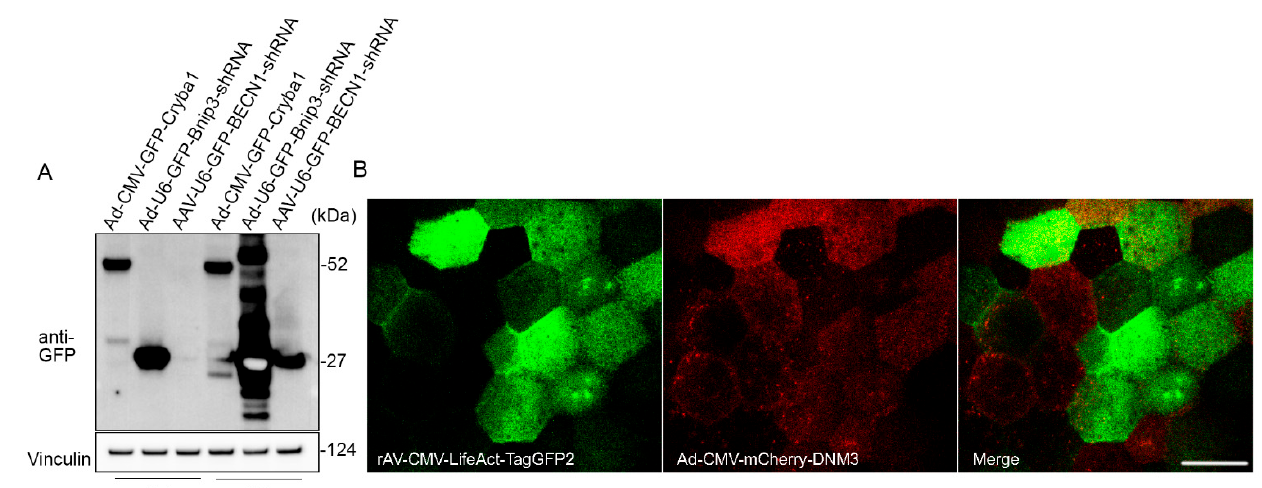
Figure 4. Adenoviral vector is an efficient tool for gene delivery in RPE flatmounts. ( A ) RPE flatmounts were infected with either adenoviral (Ad) or adeno-associated viral (AAV) constructs. All these constructs were tagged with GFP either fused or not fused with a protein. RPE flatmounts were infected either with the Ad constructs at a concentration of 8 × 10 7 PFU/mL or with AAV constructs at a concentration of 4.5 × 10 9 GC/mL. Fluorescent tag GFPs were driven by CMV promoters in both the overexpression vector and shRNA vector. The infected RPE flatmounts were collected either after 16 h or 48 h of incubation with the viral constructs. Western blotting data of the GFP levels suggested a much higher infection efficiency with adenovirus compared to AAV2, suggesting that RPE flatmounts are readily susceptible to adenovirus infection. ( B ) RPE flatmounts were infected with rAV-CMV-LifeAct-TagGFP2 and Ad-CMV-mCherry-DNM3 for 16 h. RPE flatmounts were then subjected to imaging using confocal microscopy. Scale bar = 20 μ m.